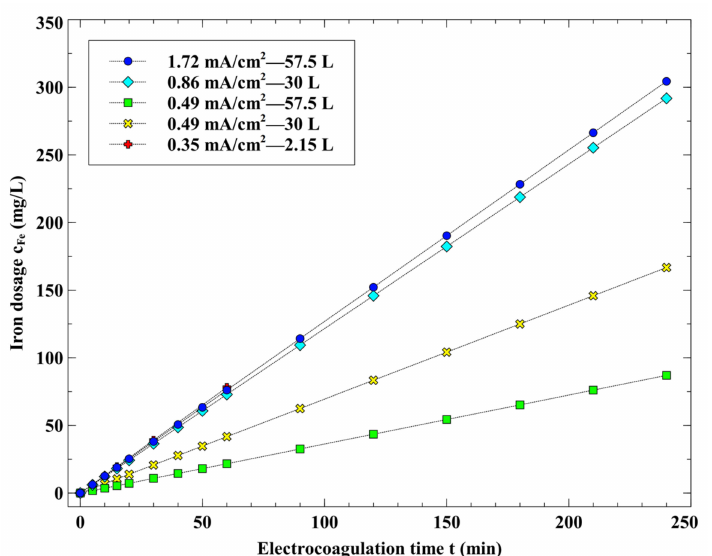
Figure 3. Calculated iron dosage according to Faraday’s law. Iron dosage of 1.72 mA/cm 2 —57.5 L and 0.35 mA/cm 2 —2.15 L are